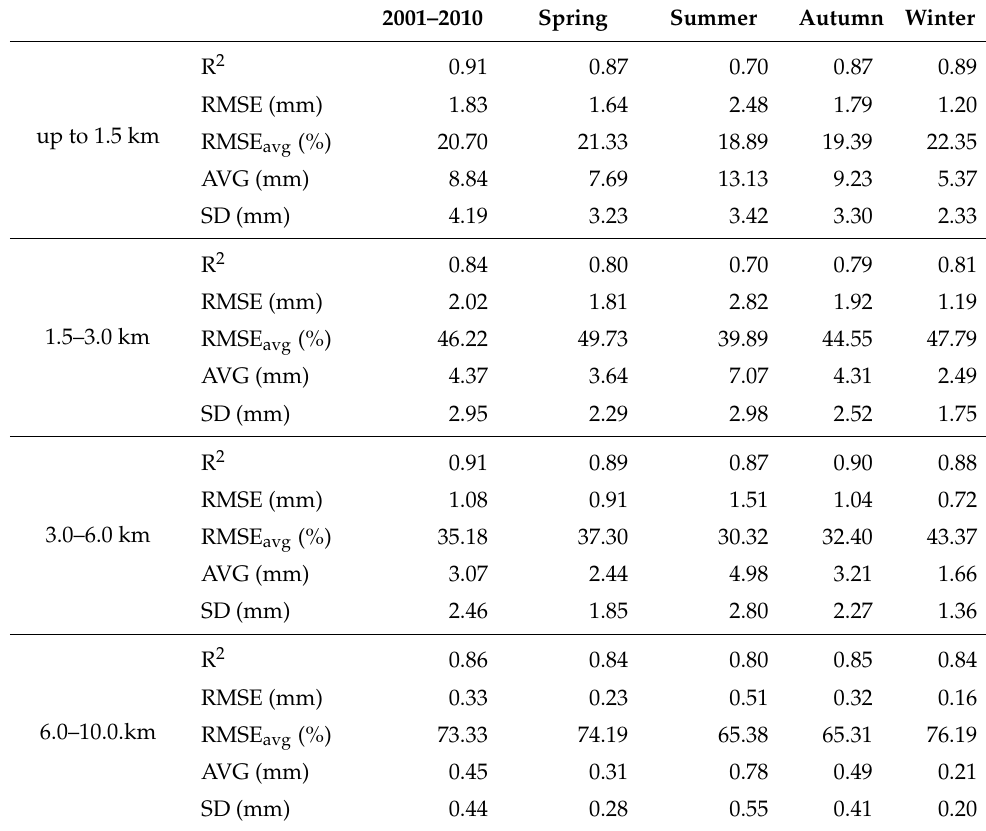
Table 4. Pearson correlation coefficients (R 2 ) and root mean square error in mm (RMSE) and % of PW average value (RMSEavg) between PW data from the WRF model and soundings for individual troposphere levels. AVG—values of averages and SD—standard deviation of PW from soundings.